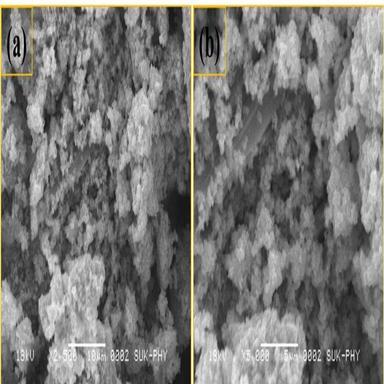
SEM images of as prepared MoS2 having X2, 500 (a) and X5, 000 (b) magnifications.